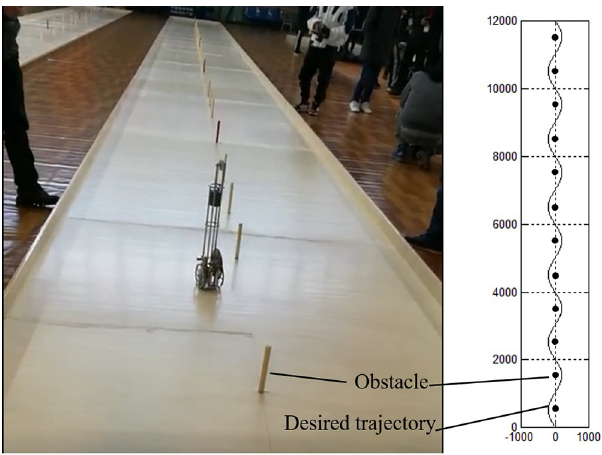
Fig. 8. “ S ” trajectory